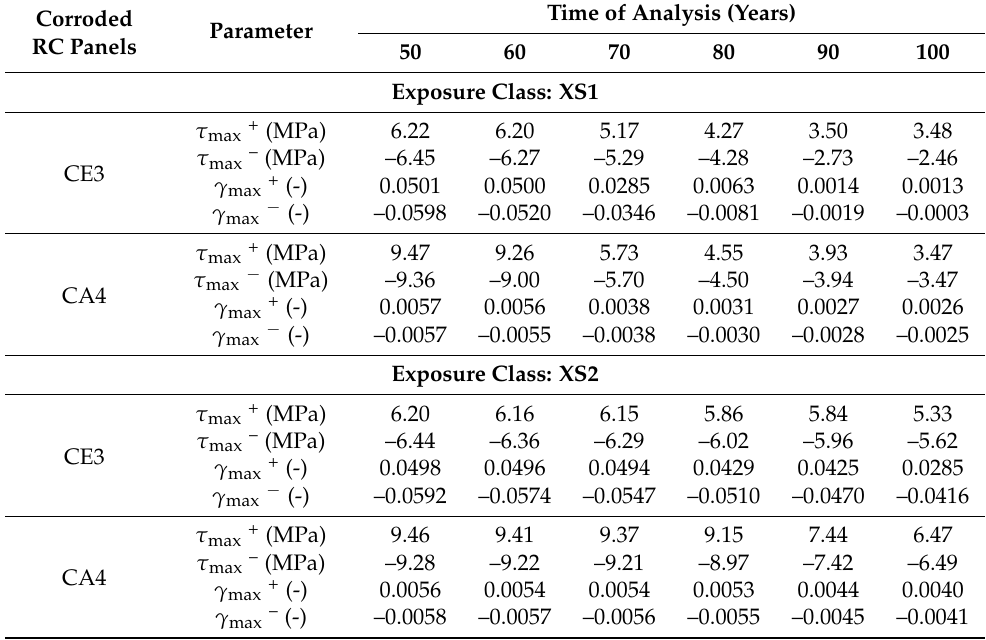
Table A1. Variation over time of the maximum shear stress and the maximum shear strain (positive and negative values) in function of different exposure classes - for the two investigated panels.